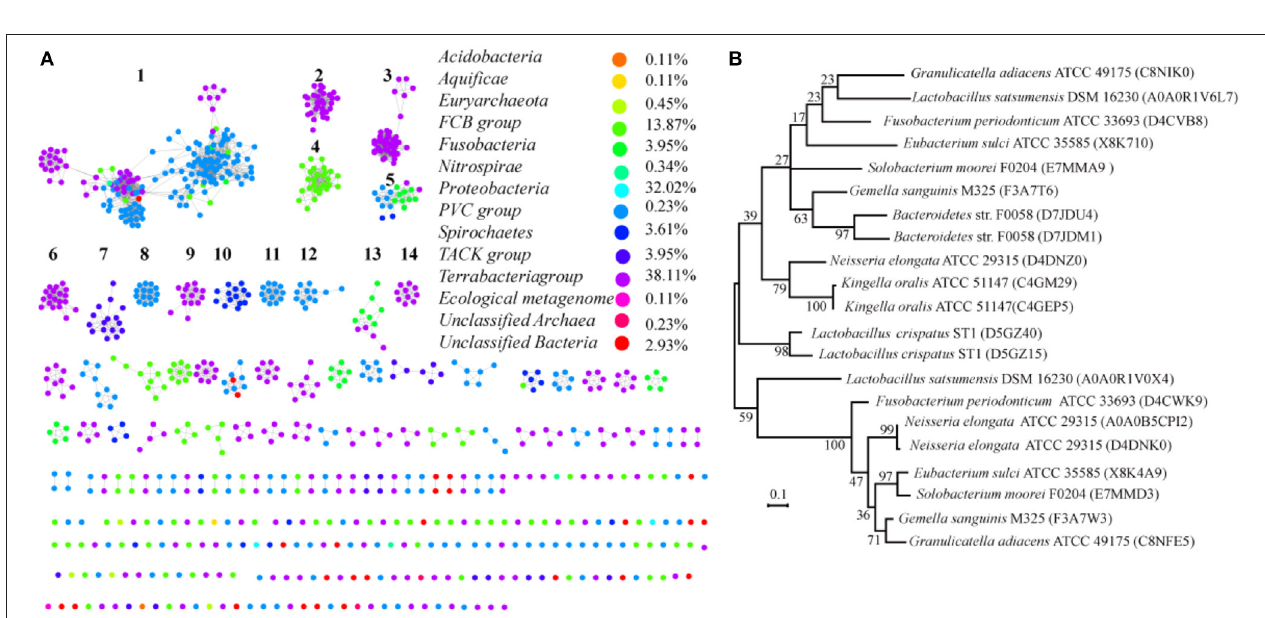
FIGURE 7 | Taxonomic distribution and evolution of SemiSWEETs in prokaryotes. (A) Distribution of SemiSWEETs. Each node represents one protein. Edges are shown with BLASTP e-values below the indicated cutoff. Clusters with more than 10 nodes are labeled sequentially. Nodes from the same taxonomic groups in the global network are the same color. The colors corresponding to the different phyla and the percentage of proteins in each phylum are listed on the right. (B) Molecular phylogenetic analysis of SemiSWEETs from bacteria with > 1 copy of the gene by the maximum likelihood method. The tree with the highest log likelihood ( − 2328.2531) is shown. The percentages of replicate trees in which the associated taxa clustered together in the bootstrap test (1,000 replicates) are shown next to the branches.